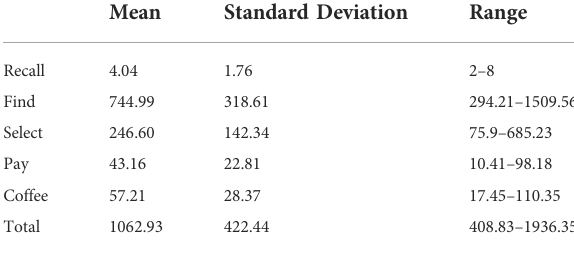
TABLE 6 Study 3 descriptive statistics for VStore